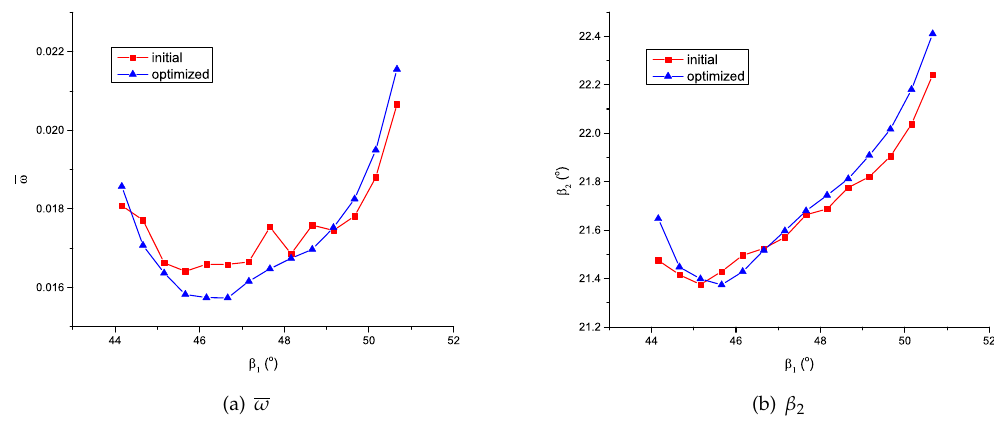
Figure 17. Aerodynamic performance curves of the cascades.